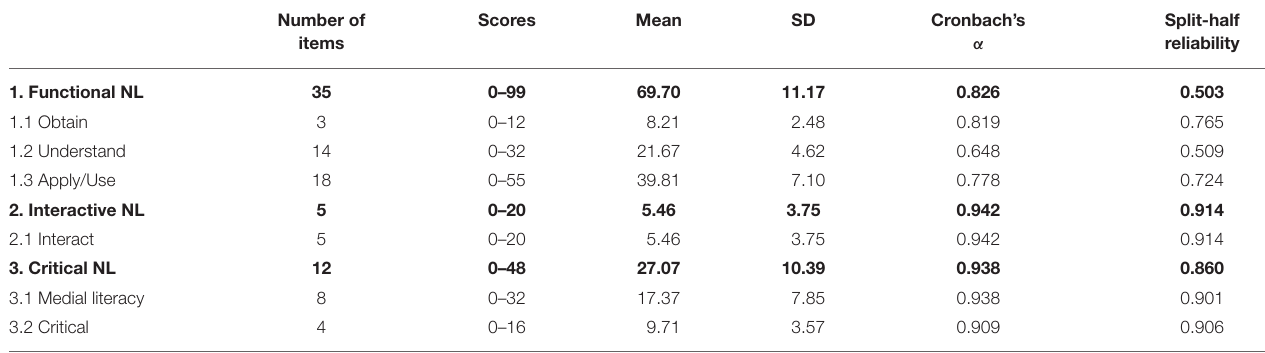
TABLE 2 | Cronbach’s α coefficient for the CM-NLS scale.